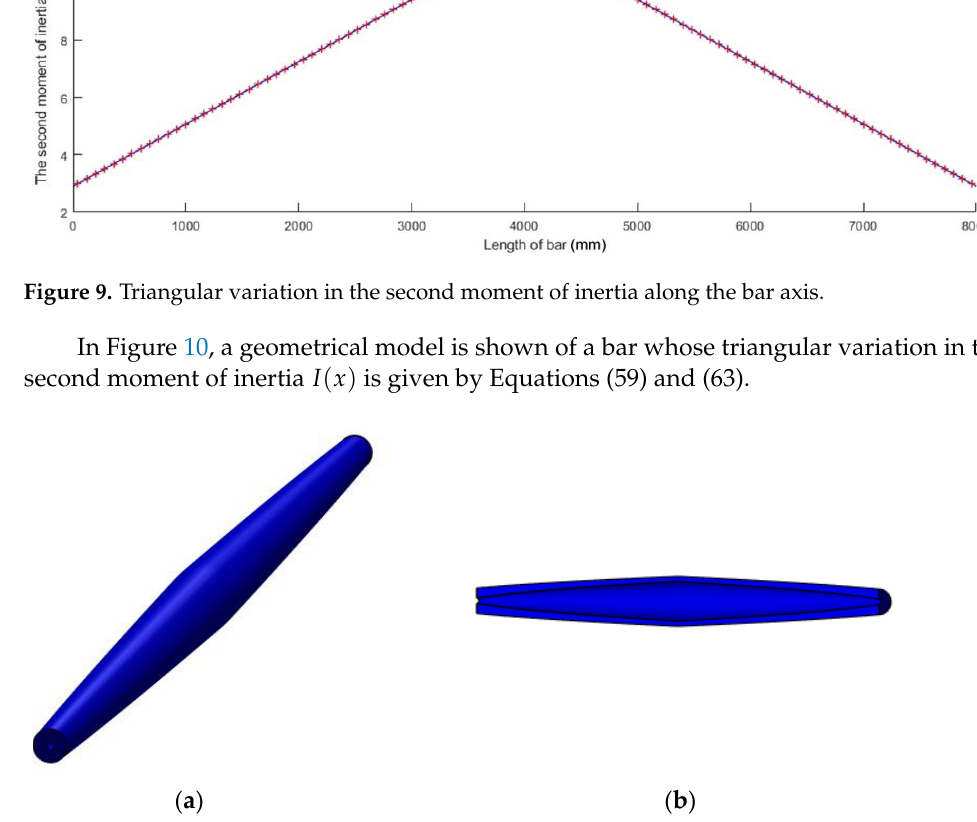
Figure 10. Geometrical model for a bar with triangular variation in the second moment of inertia along the bar axis: ( a ) isometric view and ( b ) longitudinal section.